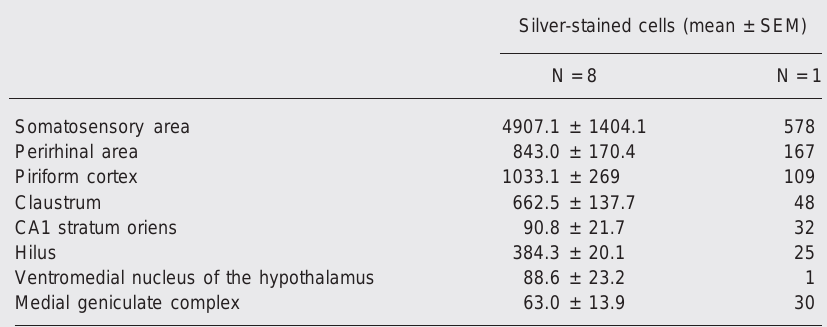
Table 1. Mean number of silver-stained cells at selected septotemporal levels in animals per- fused 2.5 h after pilocarpine-induced status